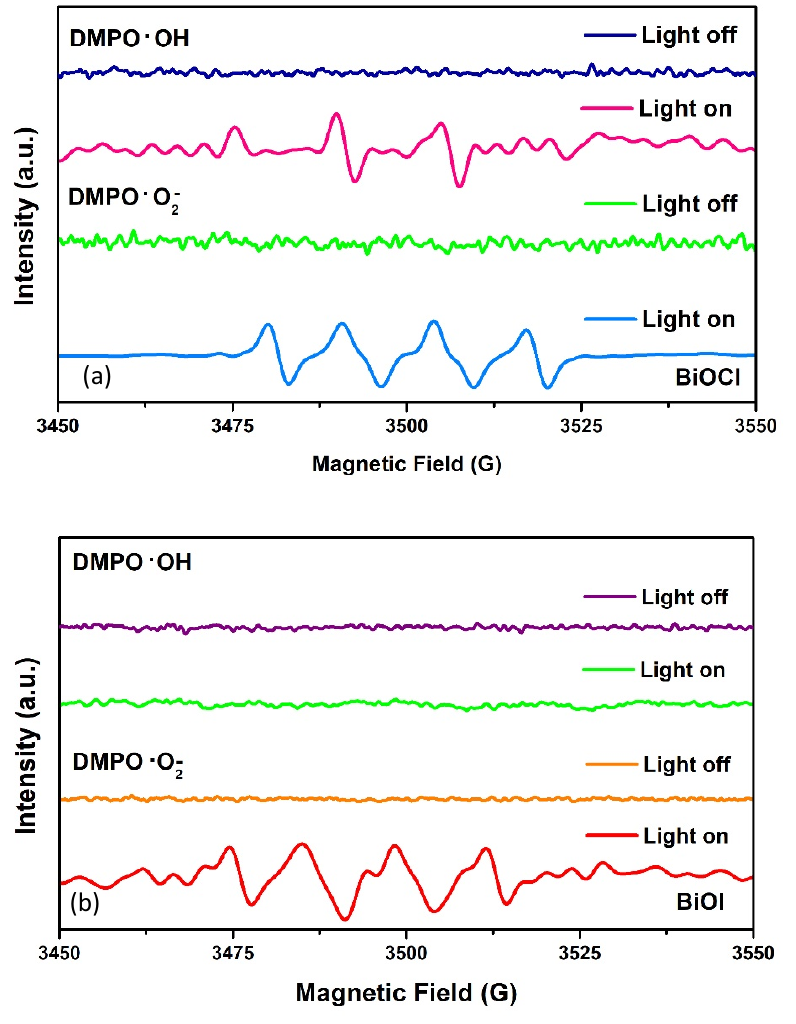
Figure 12. DMPO spin trapping Electron Paramagnetic Resonance (EPR) spectra for DMPO– • O 2 − and DMPO– • OH under visible light irradiation in neutral media with ( a ) BiOCl and ( b ) BiOI.